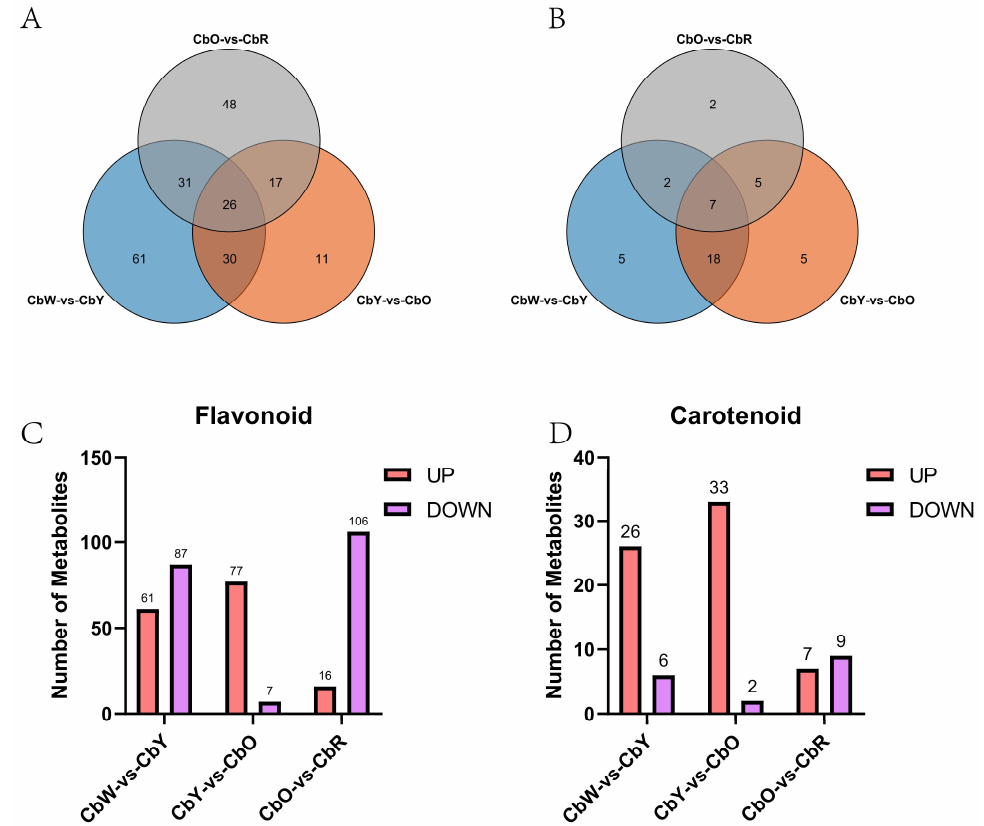
Figure 2. Metabolite analysis in CbW-vs-CbY, CbY-vs-CbO and CbO-vs-CbR. ( A ) Total number of flavonoid metabolites; ( B ) total number of carotenoid metabolites; ( C , D ) number of up- and down-regulated metabolites of flavonoids and carotenoids.